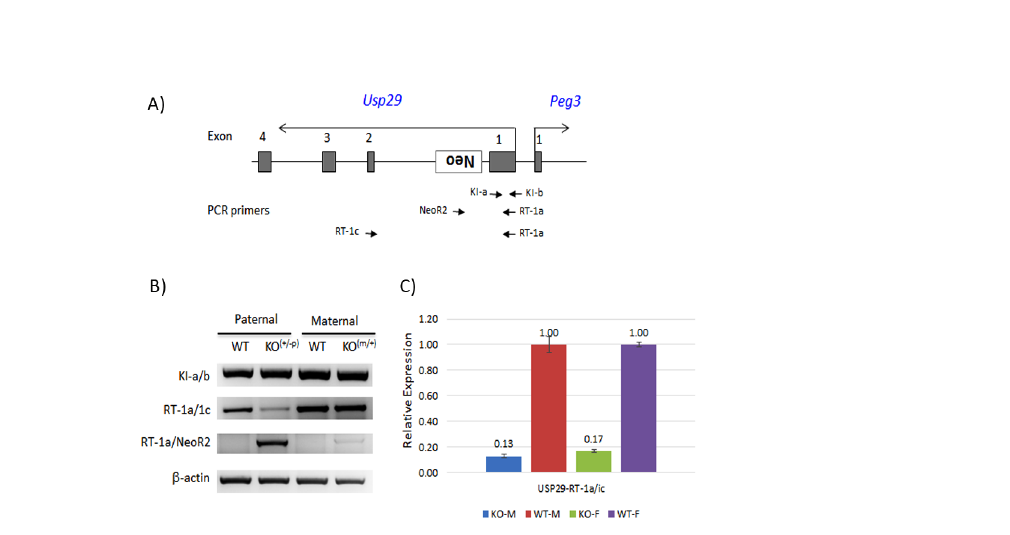
Fig 2. RT-PCR analyses testing the transcriptional truncation of Usp29 by the knockin allele. ( A ) The schematic diagram indicates the positions of three primer sets (arrows) relative to the exons of Usp29 . ( B ) A series of RT-PCR analyses were performed using the total RNA isolated from the brains of one-day-old pups with the following genotypes: wild-types (WT) and heterozygotes (KO) with the paternal (+/p) or maternal (m/ +) transmission of the knockin allele. The amounts of cDNA were normalized with an internal control ( β -actin). ( C ) The expression levels of Usp29 were measured through qRT-PCR using the primer set (RT-1a/c). This series of analyses used a set of four samples with the paternal transmission of the knockin allele: WT and KO of both genders (male and female). The expression level of each sample was first normalized with an internal control, and later the normalized levels of the KO samples were compared to those of the WT samples. These relative values were presented with standard errors (S.E.).